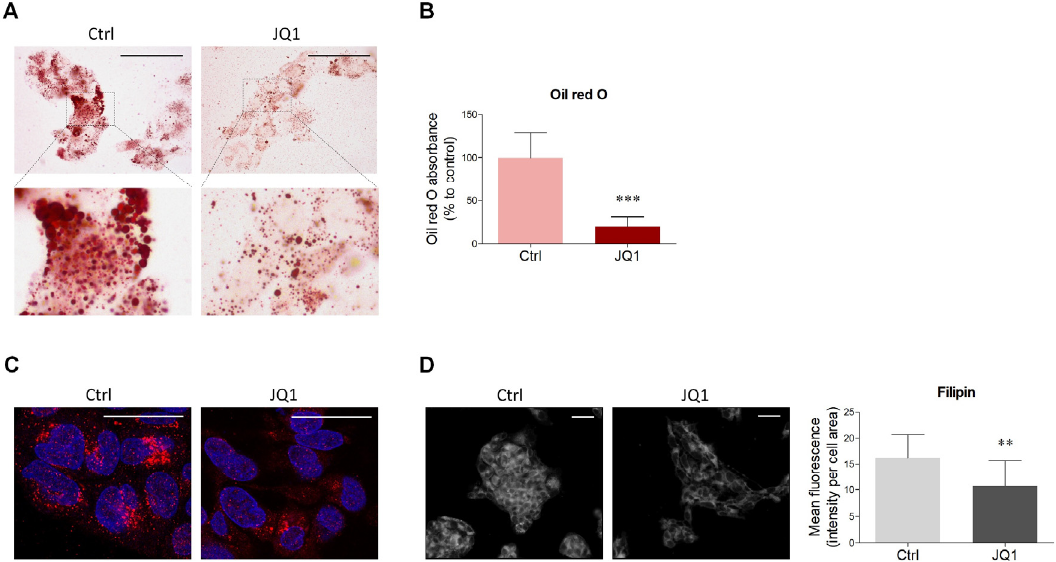
Figure 1. Effects of bromodomain and extraterminal domain (BET) inhibition by JQ1 on intracellular lipids in HepG2 cells. ( A ) HepG2 cells were treated with vehicle (Ctrl) or JQ1 (0.4 µM), and after 48 hours they were stained with Oil Red O as described in the Materials and Methods Section to visualize the intracellular content of neutral lipids. n = 6 different experiments. Scale bar: 50 µm ( B ) HepG2 cells were treated as in (A), and Oil Red O was extracted with isopropanol. The eluted dye was then quantified by spectrophotometry to evaluate the amount of neutral lipids. n = 6 different experiments. ( C ) Vehicle- and JQ1-treated HepG2 cells were fixed and stained with antibody against Plin2 (red). DAPI was used as a nuclear counterstain. Scale bar: 25 µm ( D ) Representative image (left panel) and quantification of the mean fluorescence intensity (right panel) of filipin staining performed on HepG2 cells treated with vehicle and JQ1 for 48 hours. n = 5 different experiments. Scale bar: 50 µm. Data represent means ± SD. Statistical analysis was performed by using unpaired Student’s t test. ** p < 0.01; *** p < 0.001.